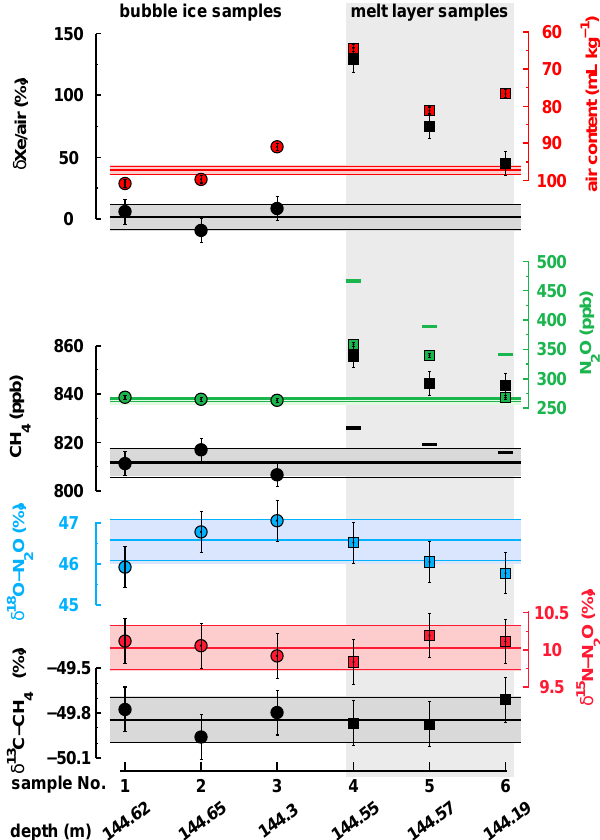
Figure 7. Results of ice core measurements (Dye 3–88, bag 145, depth is given as top of sample) with sections of bubble ice and sec- tions including melt layers. Samples consisting of bubble ice only (no. 1–3) are shown as circles and samples with melt layers (no. 4– 6) are shown as squares within grey shading. Note that air content is plotted on an inverse axis. For CH 4 and N 2 O, green and black bars, respectively, indicate calculated values in the melt layer samples as- suming that both species are affected by equilibrium solubility ef- fects as derived from the δ Xe / air anomaly. Error bars represent the average standard deviation derived from replicate samples (see Ta- ble 4). Horizontal shading and lines in the respective species’ colour represent the mean of the bubble ice measurements and 1 σ of the typical reproducibility (Tables 4 and